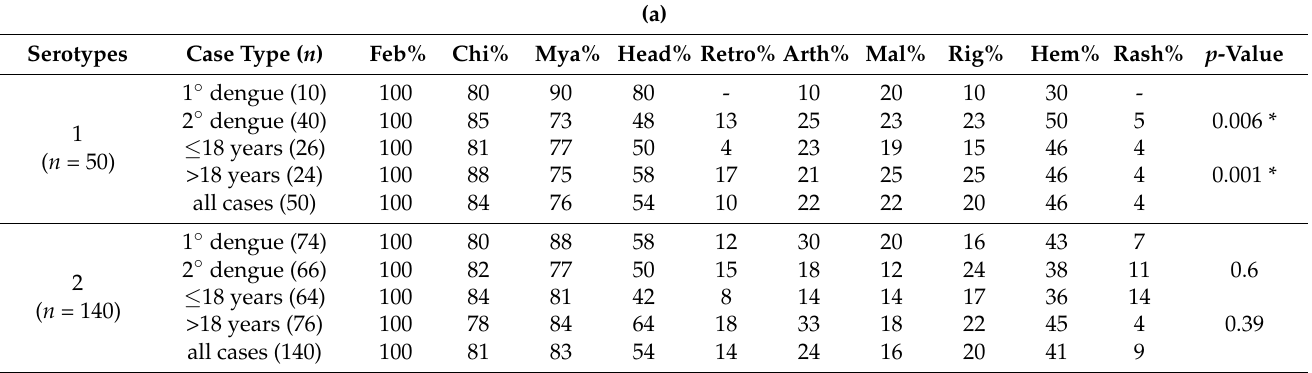
Figure 1. Trends of occurrence of different Dengue virus serotypes and their co-infections in the given geographic location during January 2017 to December 2017. Dengue cases were occurring throughout the year, with seasonal peaks in July and October months. During outbreaks all four dengue serotypes were observed with DENV-2 predominance. There were no hotspot regions observed during the study period in this (Raayalaseema region, Andhra Pradesh, India) part of the state. Table 3. ( a ) Signs and symptoms recorded in primary and secondary dengue infections and pediatric and adult populations. ( b ) Signs and symptoms recorded in primary and secondary dengue infections and pediatric and adult